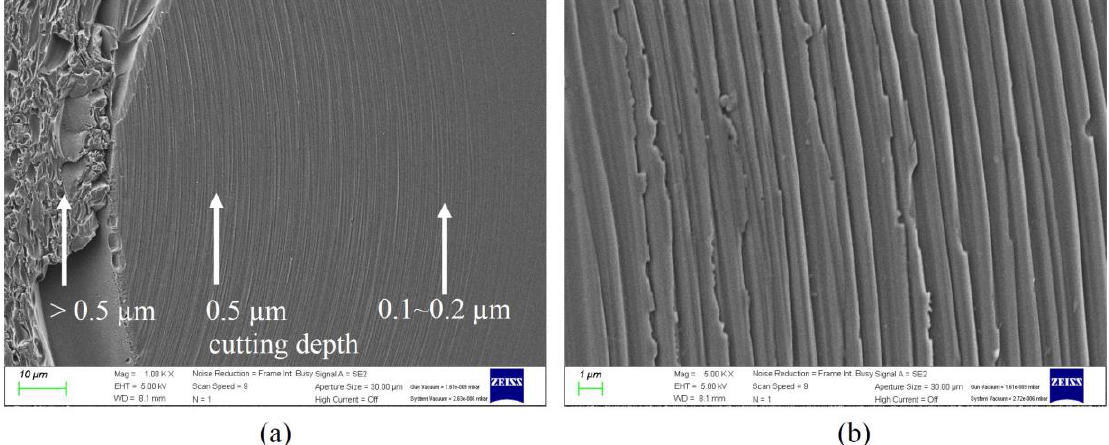
Figure 15. ( a ) The channel bottom machined with varying cutting depths and ( b ) an enlarged view of the channel